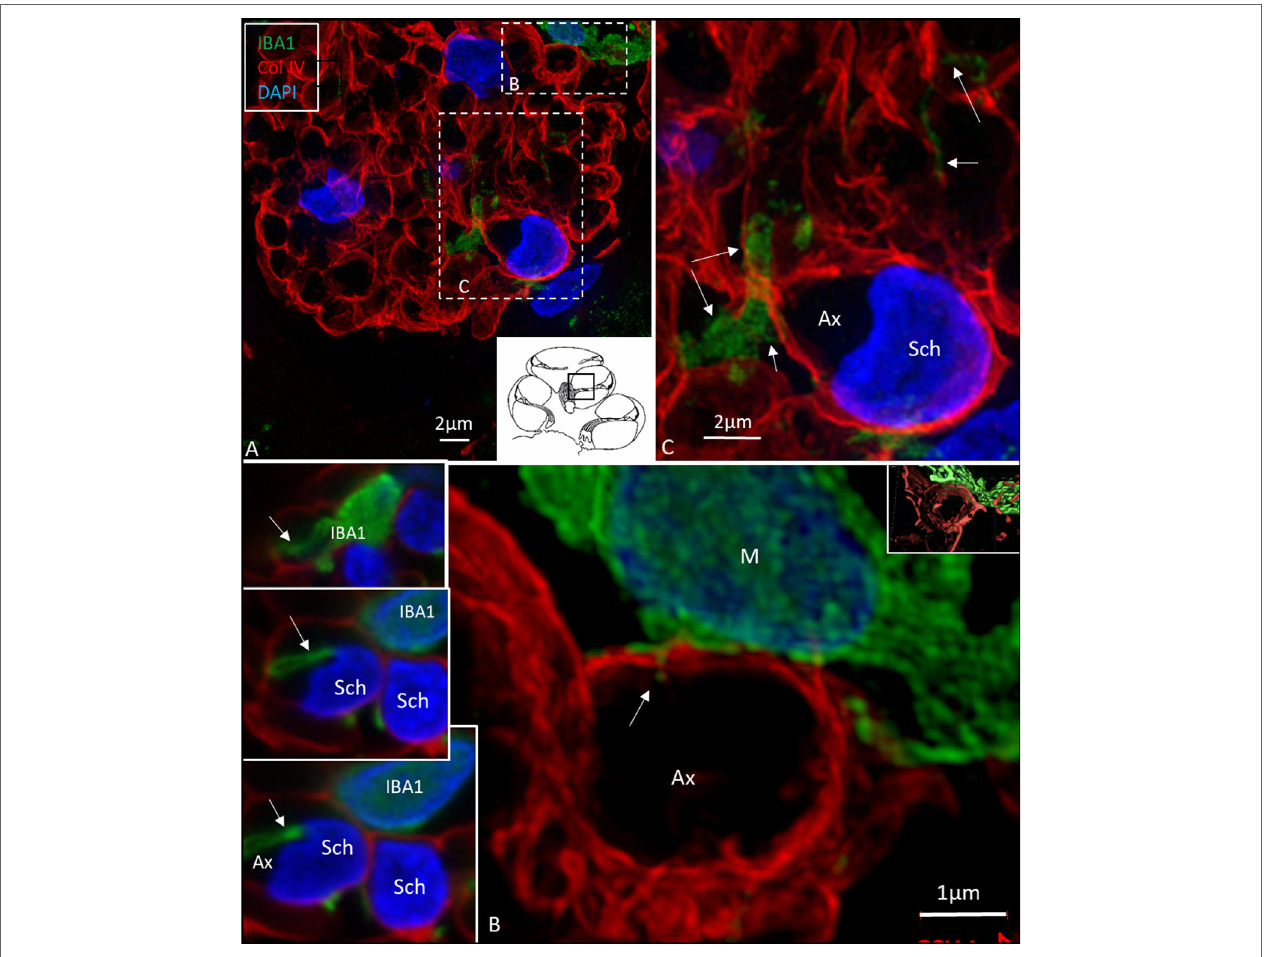
FigUre 8 | Ionized calcium-binding adaptor molecule 1 (IBA1) cells perforate basal lamina (BL) of Schwann cells. (a) SR-SIM (maximum intensity projection) of IBA1 macrophages (M) in a cross-sectioned nerve bundle in the spiral lamina (second turn, inset). Framed areas are shown in higher magnification in panels (b,c) . Macrophages (M, green) send projections to adjacent axons (Ax). (b) An IBA1 cell process penetrates the BL of a Schwann cell (arrow). Inset shows 3D video reconstruction in Video S2 in Supplementary Material. Serial optical sections (b) show IBA1 cell process entering the peri-neuronal space (insets, arrows). (c) IBA1 cells send many projections to surrounding axons in the spiral lamina (arrows). Sch, Schwann